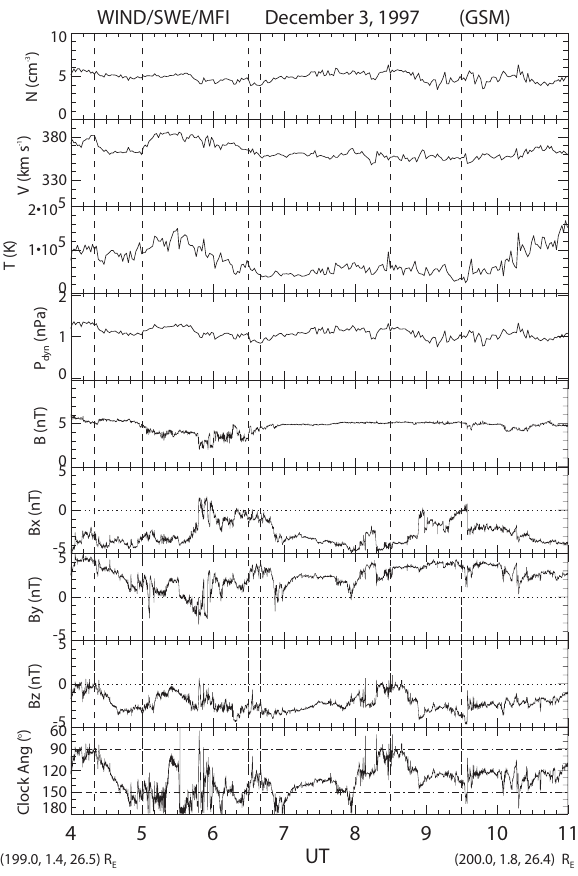
Figure 1 Fig. 1. Solar wind plasma and IMF observations from spacecraft Wind during the interval 04:00–01:00 UT on 3 December 1997. Panels from top to bottom shows proton density, bulk speed, tem- perature, solar wind dynamic pressure, the total field intensity and the GSM components ( B x , B y , and B z ) of the interplanetary mag- netic field (IMF). The three selected intervals for which we re- port/discuss dayside auroral observations are indicated by vertical